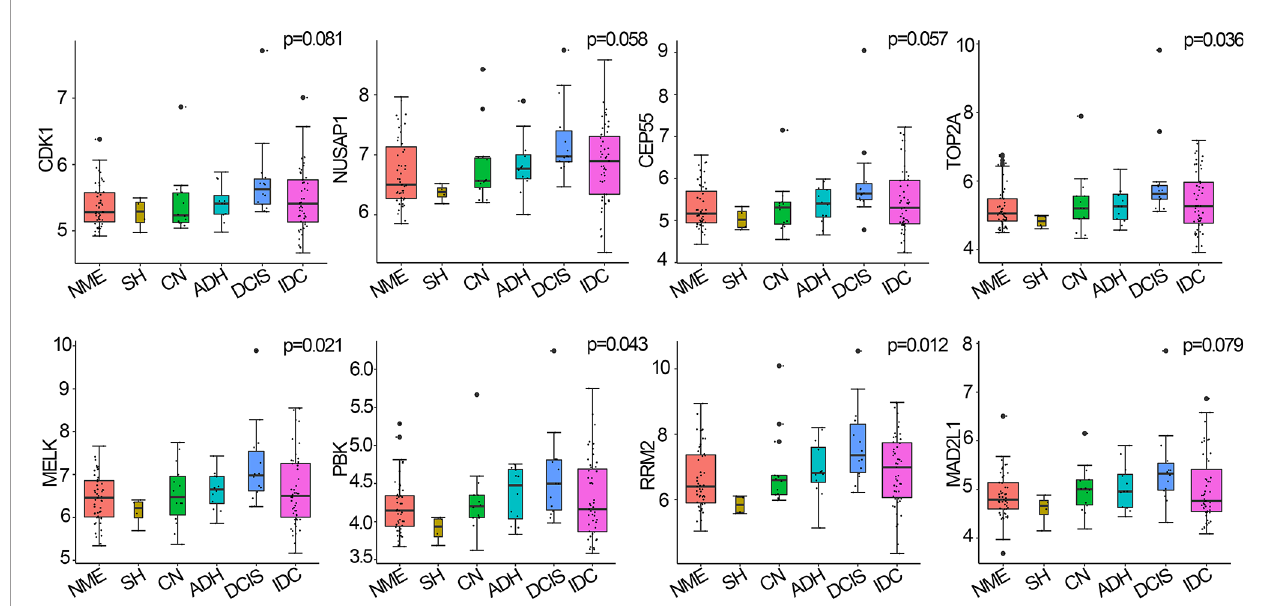
FIGURE 4 | Hub genes expressed in breast cancer and normal tissues, using the Curtis breast dataset (n=146). p-values were calculated via log-rank test and p<0.05 was considered signi fi cant. NME, normal mammary epithelium; SH, simple ductal hyperplasia; CN, cancer normal; ADH, atypical ductal hyperplasia; DCIS, ductal carcinoma in situ; IDC, invasive ductal carcinoma.